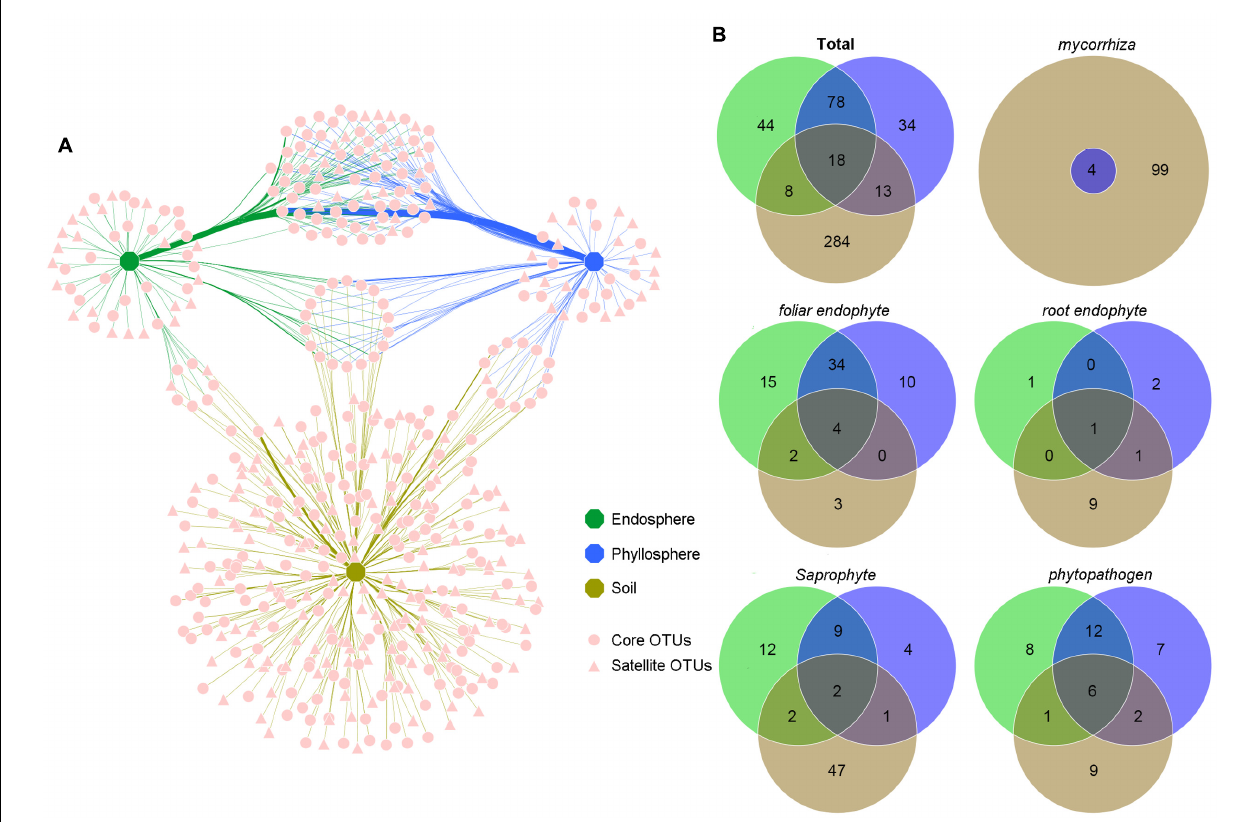
FIGURE 4 | Operational taxonomic unit (OTU) network map and venn diagrams of the different habitats (OTU numbers). (A) OTU network map of total fungi communities across habitats. Each pink point represents an independent fungal OTU (479 OTUs; sequences were subsampled to 35,328 per habitat). Edges show which OTUs belonged to which Habitat. Edge thickness was weighted by the abundances from the OTU to the specific habitat. Different shaped points represent core or satellite OTUs in each habitat. (B) Venn diagrams of total fungal communities and five functional guilds among habitats. Green, blue and khaki represent samples belonging to the endosphere, phyllosphere and soil,